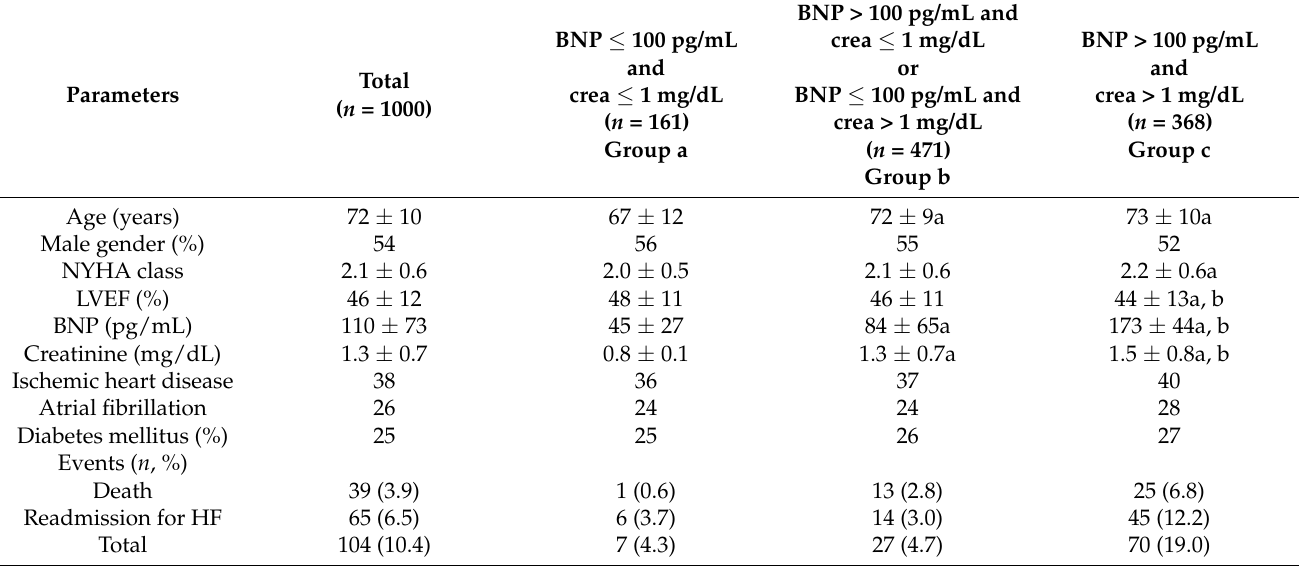
Table 1. Clinical and demographic characteristics of the study